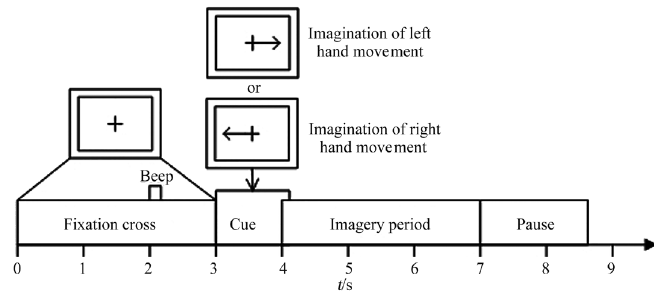
Figure 4. MI without recognition feedback